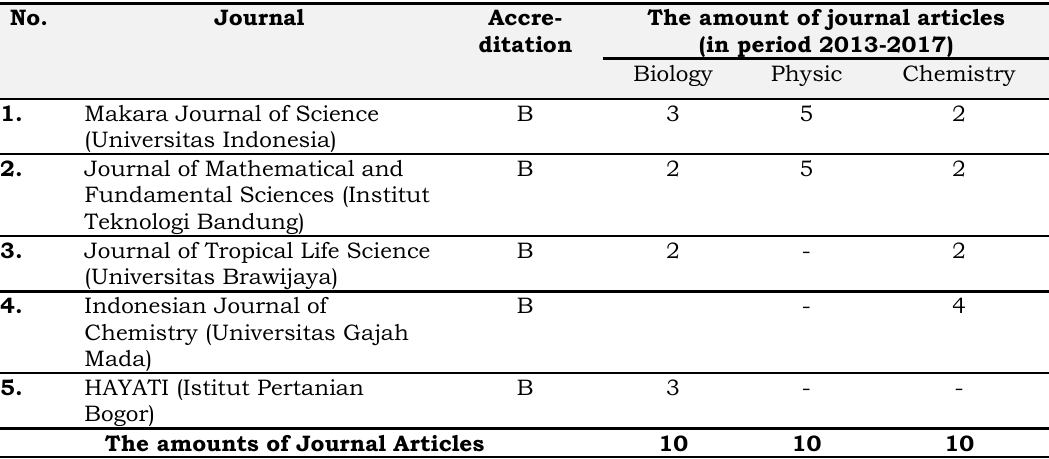
Table 1. The Corpus of this